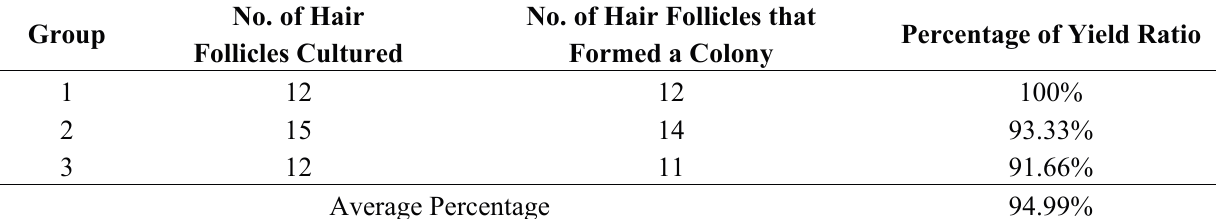
Table 1. The colony-forming ratio of ovine vibrissa hair